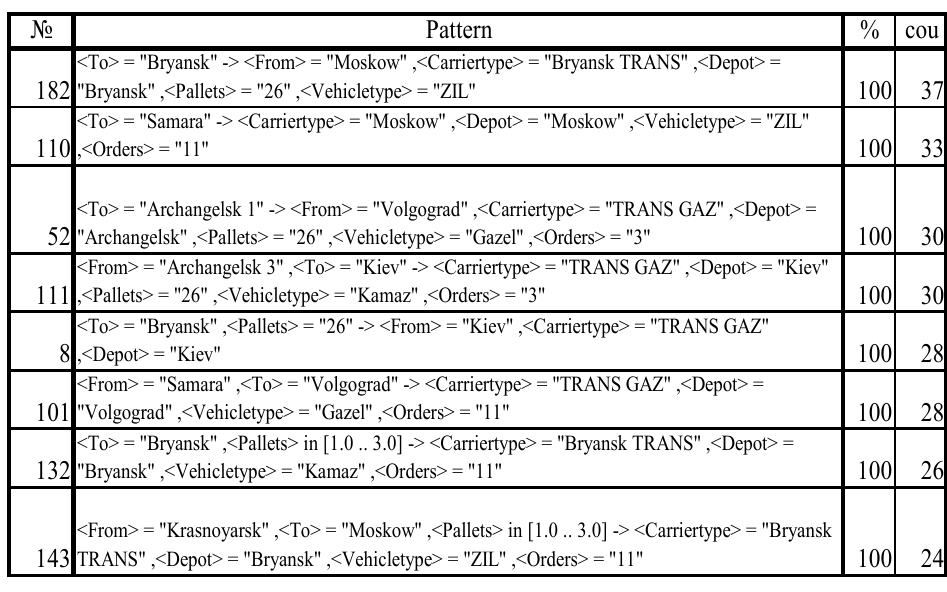
Figure 6. Examples of the discovered rules.